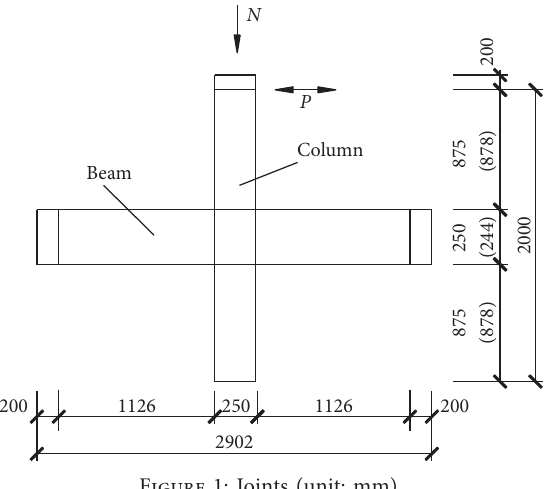
Figure 1: Joints (unit: mm). Table 1: Details of joint specimens.